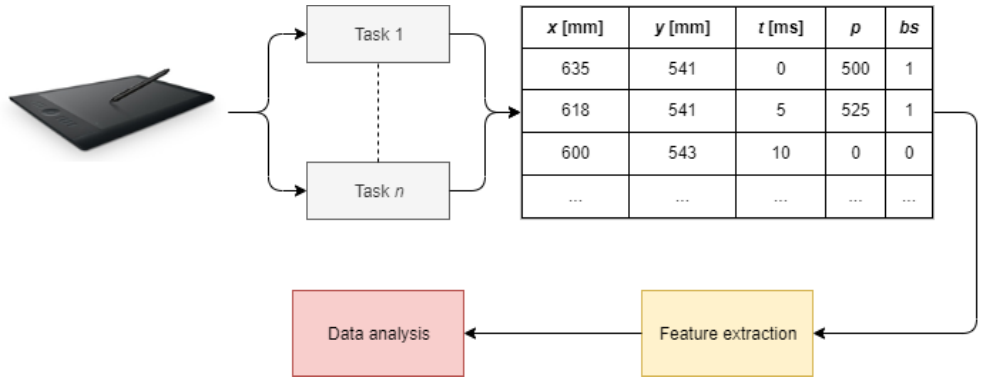
Figure 1. Typical workflow of dynamic handwriting analysis ( t stands for timestamp, p stands for pressure, and bs stands for button status).